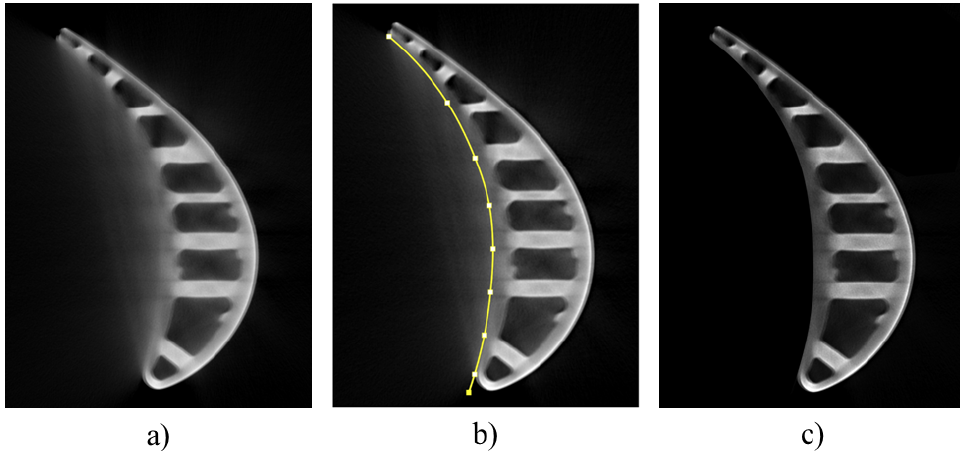
Figure 2. ( a ) The original ICT image; ( b ) the contour fitting; ( c ) the label without artifacts for ( a